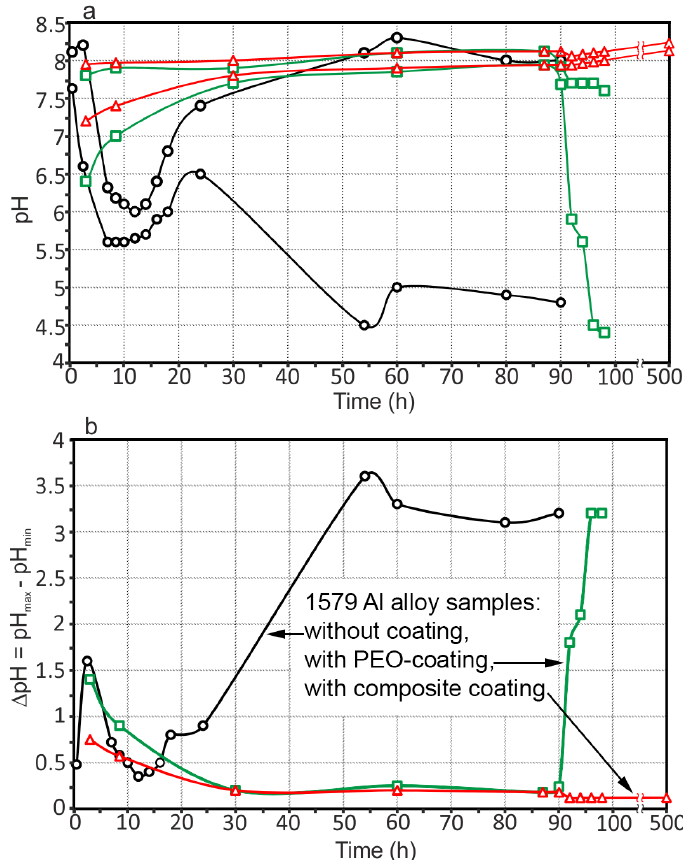
Figure 10. ( a ) Maximum and minimum pH as a function of time and ( b ) ∆ pH evolution with time for 1579 Al alloy samples without coating, with a PEO-layer, and with composite polymer-containing coating. The sample with composite coating demonstrates the smallest variations of ∆ pH, which is around 0.12–0.15 during all the exposure